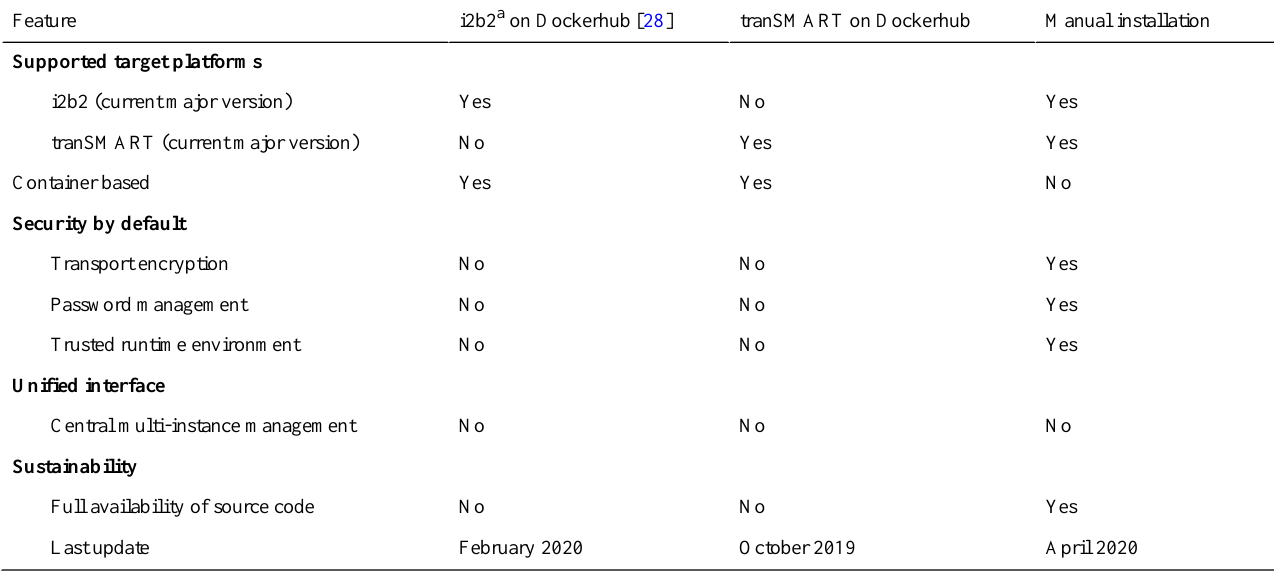
Table 5. Comparison of provisioning infrastructures: i2b2 a on Dockerhub, tranSMART on Dockerhub, and manual